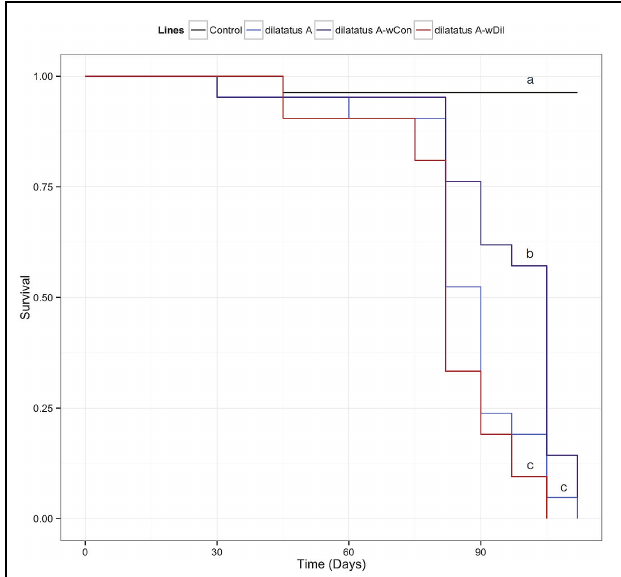
Figure 4C ; for P. dilatatus : W = 90, p = 1, Figure 4D